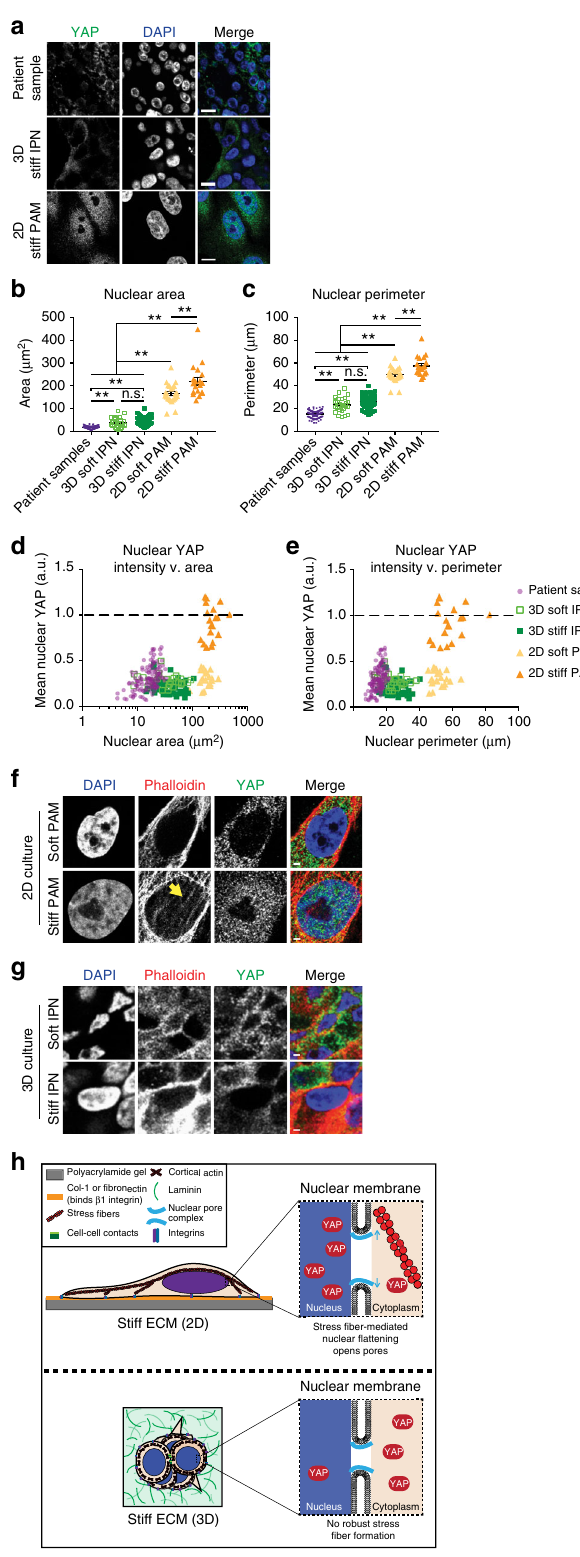
Fig. 3 Nuclear morphologies are distinct between 2D and 3D culture and in vivo. a Images of nuclear morphologies and YAP. Bars: 10 µ m. b Areas and c perimeters of nuclei. ** p < 0.005, one-way ANOVA followed by Tukey post hoc comparison tests, symbols represent each cell, n = 19 – 132 nuclei per condition, lines display mean ± SEM. Measurements were taken from distinct samples. Patient samples from fi ve DCIS patients. YAP intensity with nuclear d area and e perimeter. Values normalized by positive controls within each sample. Dotted line represents positive nuclear YAP. Purple dots: patient samples; light green squares: 3D soft IPN; fi lled dark green squares: 3D stiff IPN; fi lled light orange triangles: 2D soft PAM; fi lled orange triangles: 2D stiff PAM. F-actin staining in f 2D or g 3D culture. Arrow indicates perinuclear stress fi bers. Bars: 2 µ m. h Model of stiffness-induced YAP localization in 2D vs.